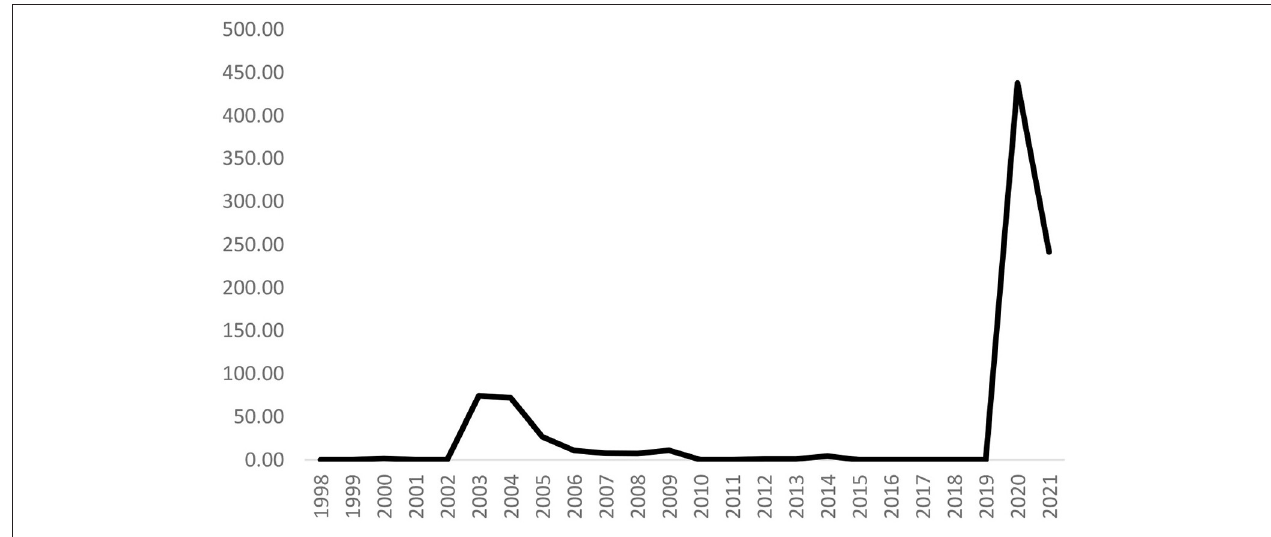
FIGURE 1 | Pandemics discussion index in China (Annual, 1998–2021Q2). Data source: https://worlduncertaintyindex.com/data/, based on Ahir et al. (59).